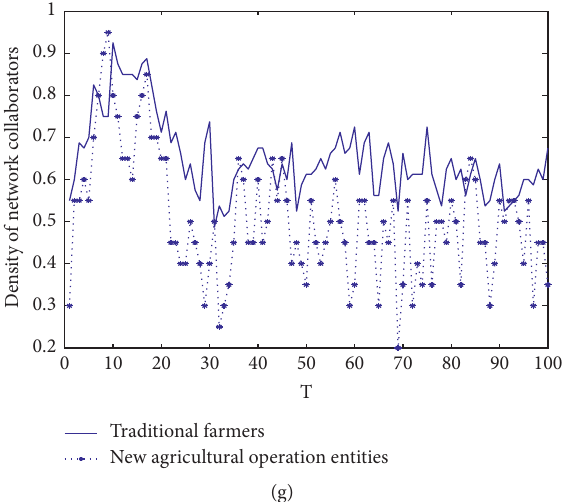
Figure 1: Evolution of parameter changes on green agricultural production network under the market